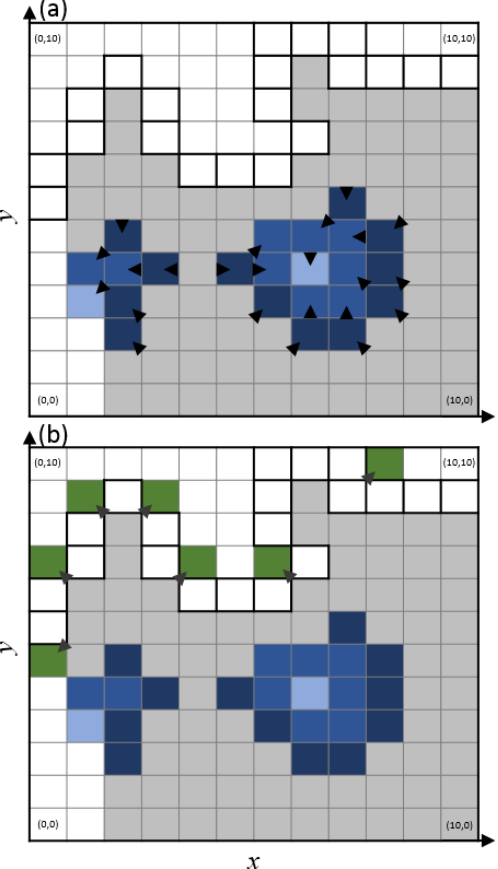
Figure 6. Schematic example of the reverse platform filling pro- cess. (a) Step 5.1: filling of empty cells adjacent to Pc n cells (grey, dark blue, and blue cells) with an order n − 1 (dark blue, blue, and light blue cells). (b) Step 5.2: filling of empty cells adjacent to Pc n cells (grey cells) with an order n − 1 (green cells) when scarp cells (black outlines) are included in the platform ensemble. The arrows indicate the dispersion